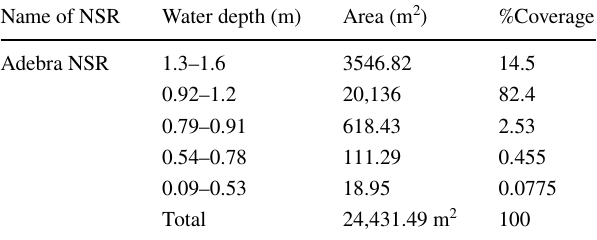
Table 4 Summery of three NSR bathymetry survey water depths in terms of area coverage